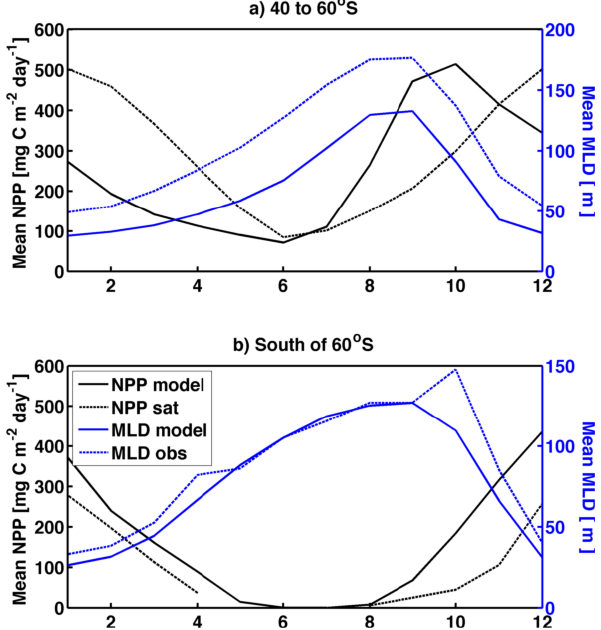
Figure 19. Seasonal change in mean modelled and observed NPP (SeaWIFS, 2012; Behrenfeld and Falkowski, 1997) and MLD (de Boyer Montegut et al., 2004) for (a) the Southern Ocean from 40 to 60 ◦ S and (b) south of 60 ◦